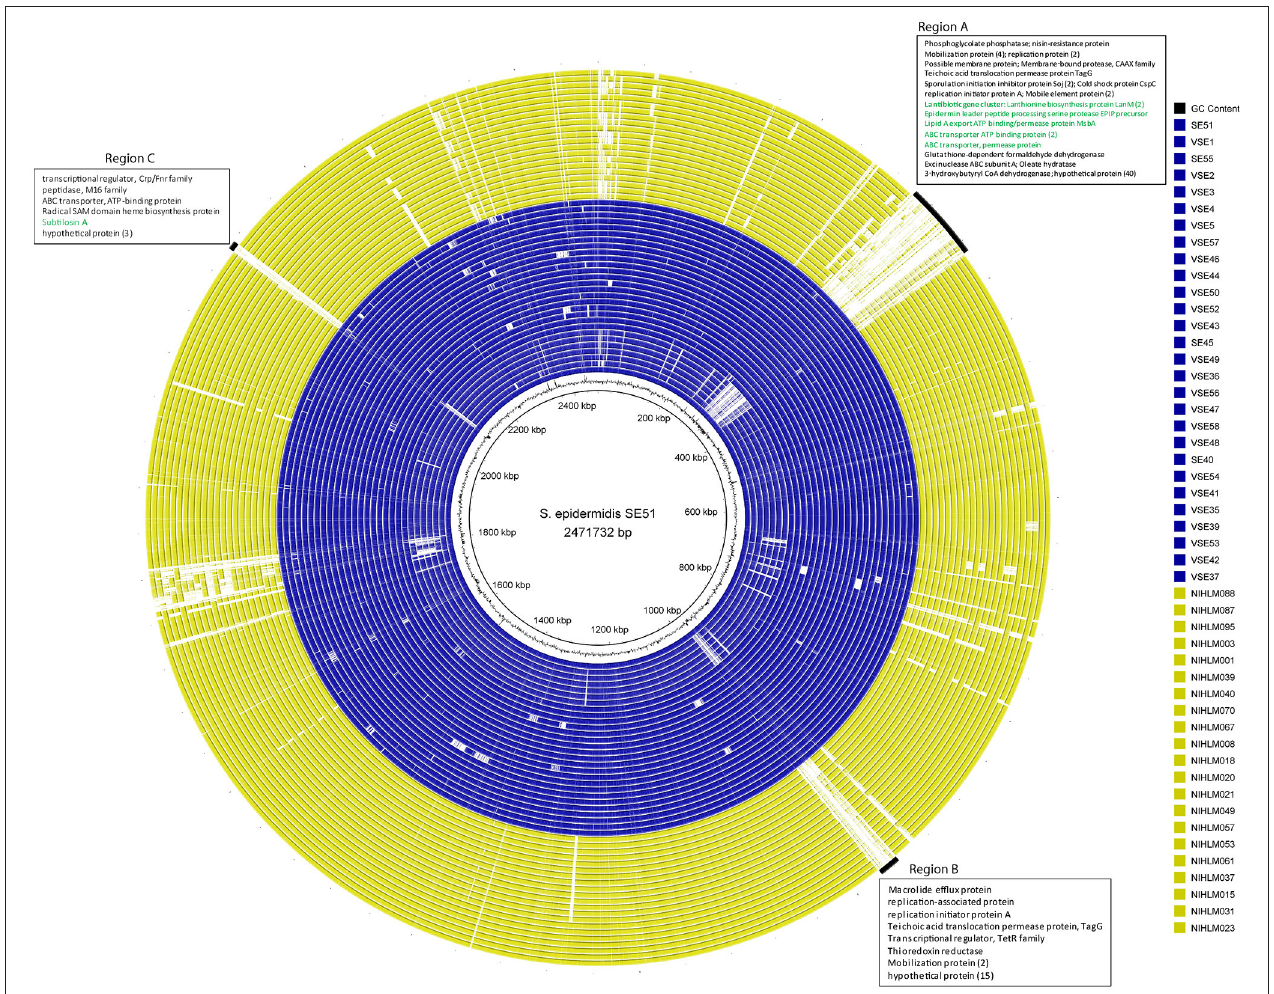
FIGURE 6 | Blast based whole genome comparison of SEI and SEA isolates, taking Indian commensal, SE51 as reference. Blue color represents SEI isolates and yellow color represents SEA isolates. SEI isolates of PG1 lineage were seen to have three large dynamic regions with annotation indicated within boxes as region A, B, and